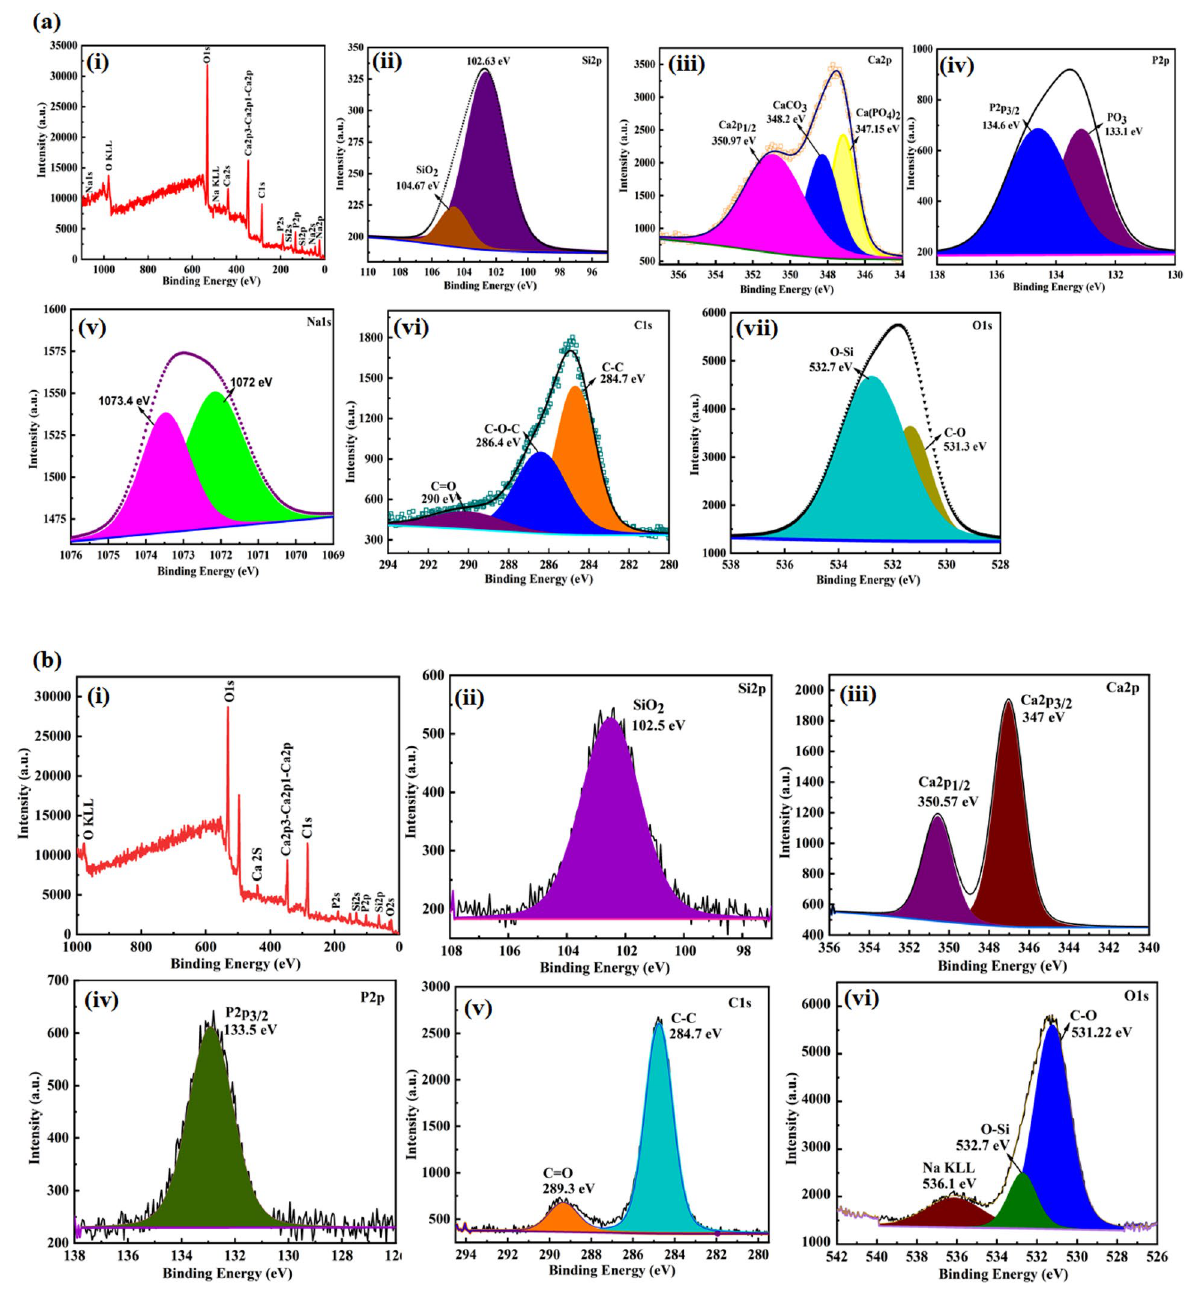
Figure 16. XPS spectra of ( a ) BG/GO, ( b ) BG (Na-free)/GO nanocomposites, ( c ) BG (Na-free), ( d ) BG, ( e ) GO. The survey and core-level spectrum of Si 2p, Ca 2p, P 2p, Na 1s, C1s, and